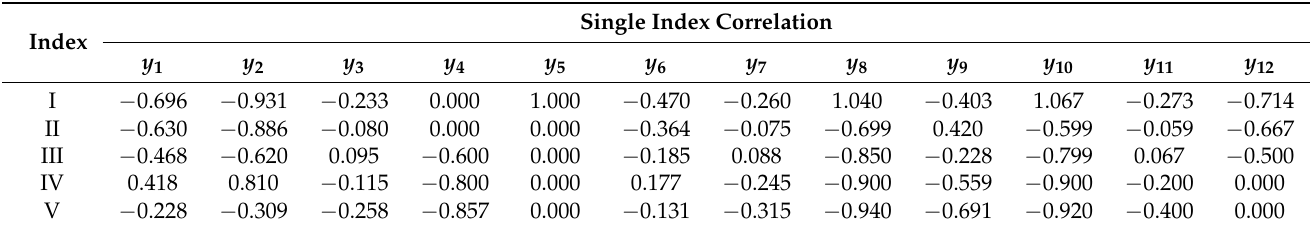
Table 5. Single index correlation of the slope rock mass X 1 .